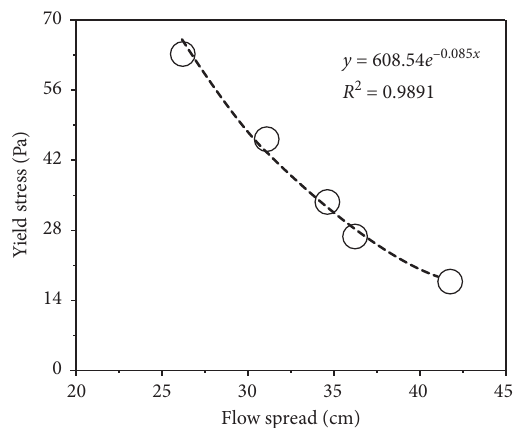
Figure 9: UCS variation with fine